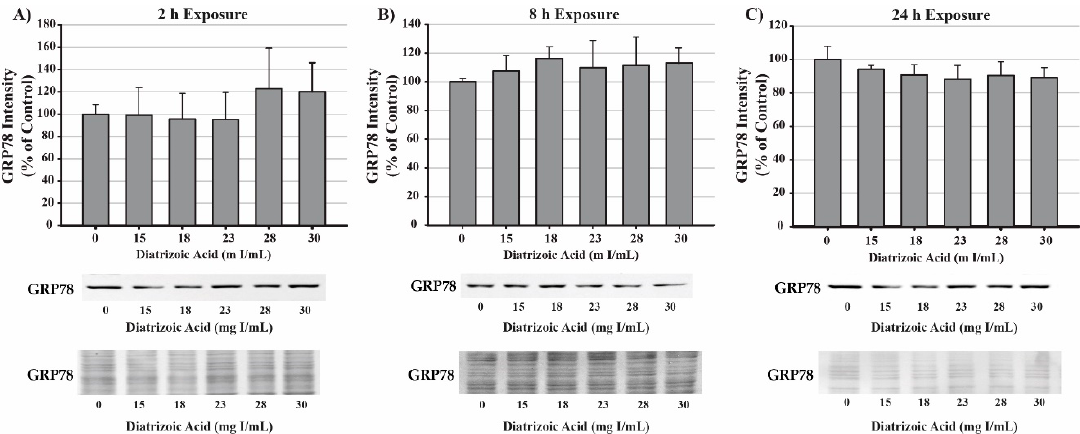
Figure 9. Diatrizoic acid effects on GRP78 expression in HK-2 cells. DA did not activate the unfolded protein response (UPR). Representative blots and cumulative densitometry included for glucose-regulated protein 78 (GRP78) expression following 2 h ( A ), 8 h ( B ), and 24 h ( C ) exposure to DA. Protein loading of 40 µg in each lane was visualized with Memcode reversible stain and depicted below each GRP78 blot. Values represent mean ± SEM for three independent experiments.